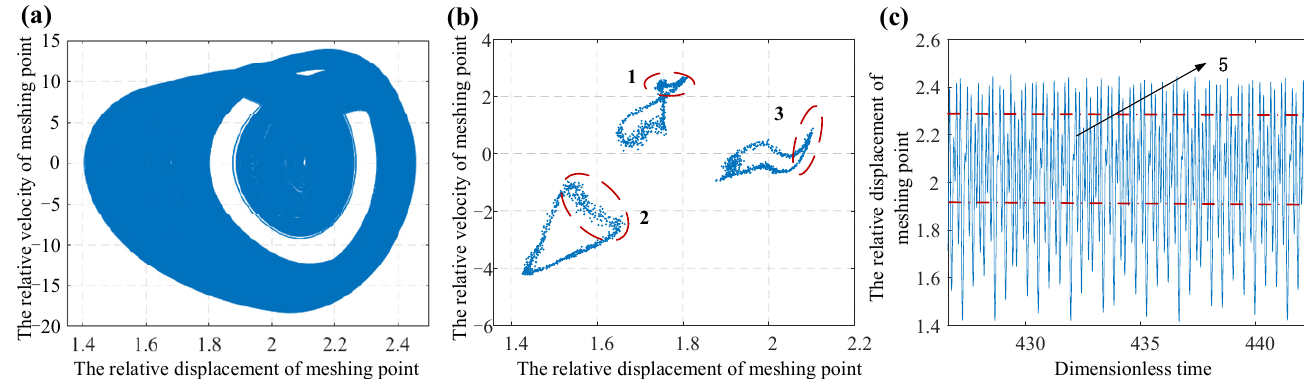
Figure 12. System response diagram with D = 1.6. ( a ) Phase diagram. ( b ) Poincare section diagram. ( c ) Time domain diagram.